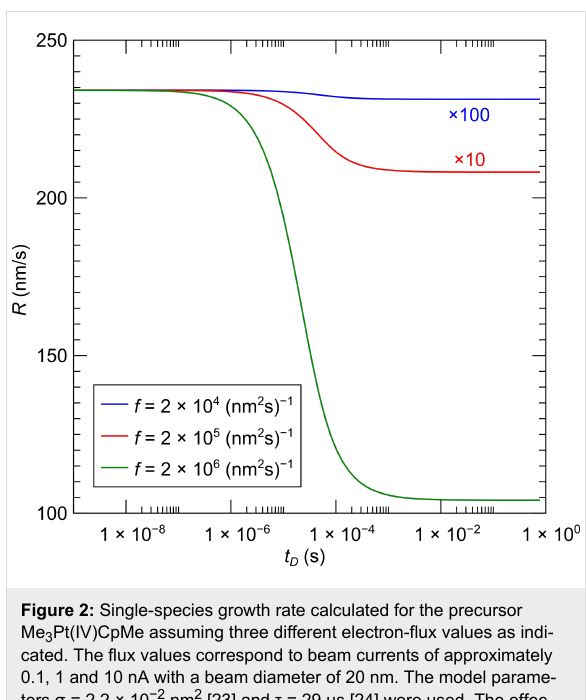
Figure 2: Single-species growth rate calculated for the precursor Me 3 Pt(IV)CpMe assuming three different electron-flux values as indi- cated. The flux values correspond to beam currents of approximately 0.1, 1 and 10 nA with a beam diameter of 20 nm. The model